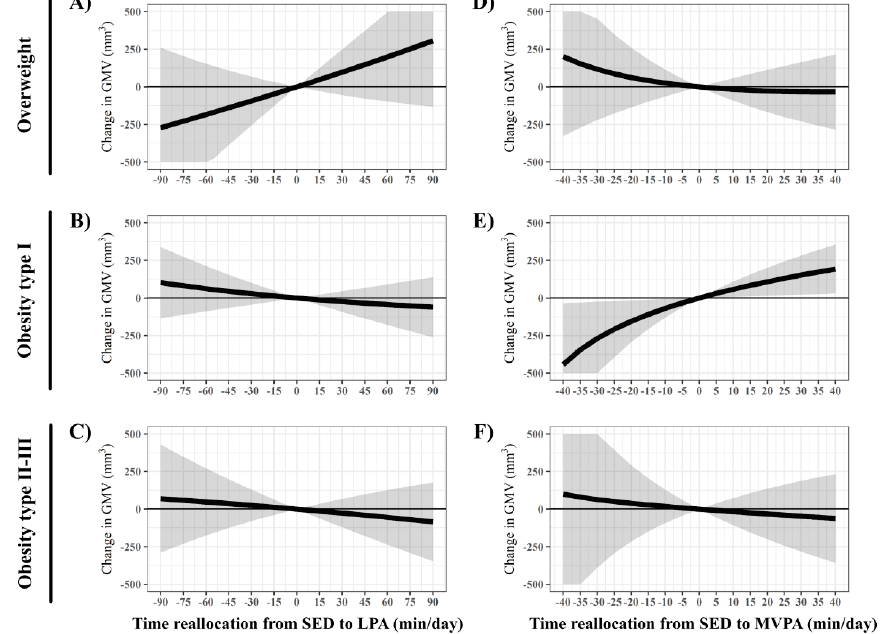
2), isotemporal reallocations were not depicted for this region.